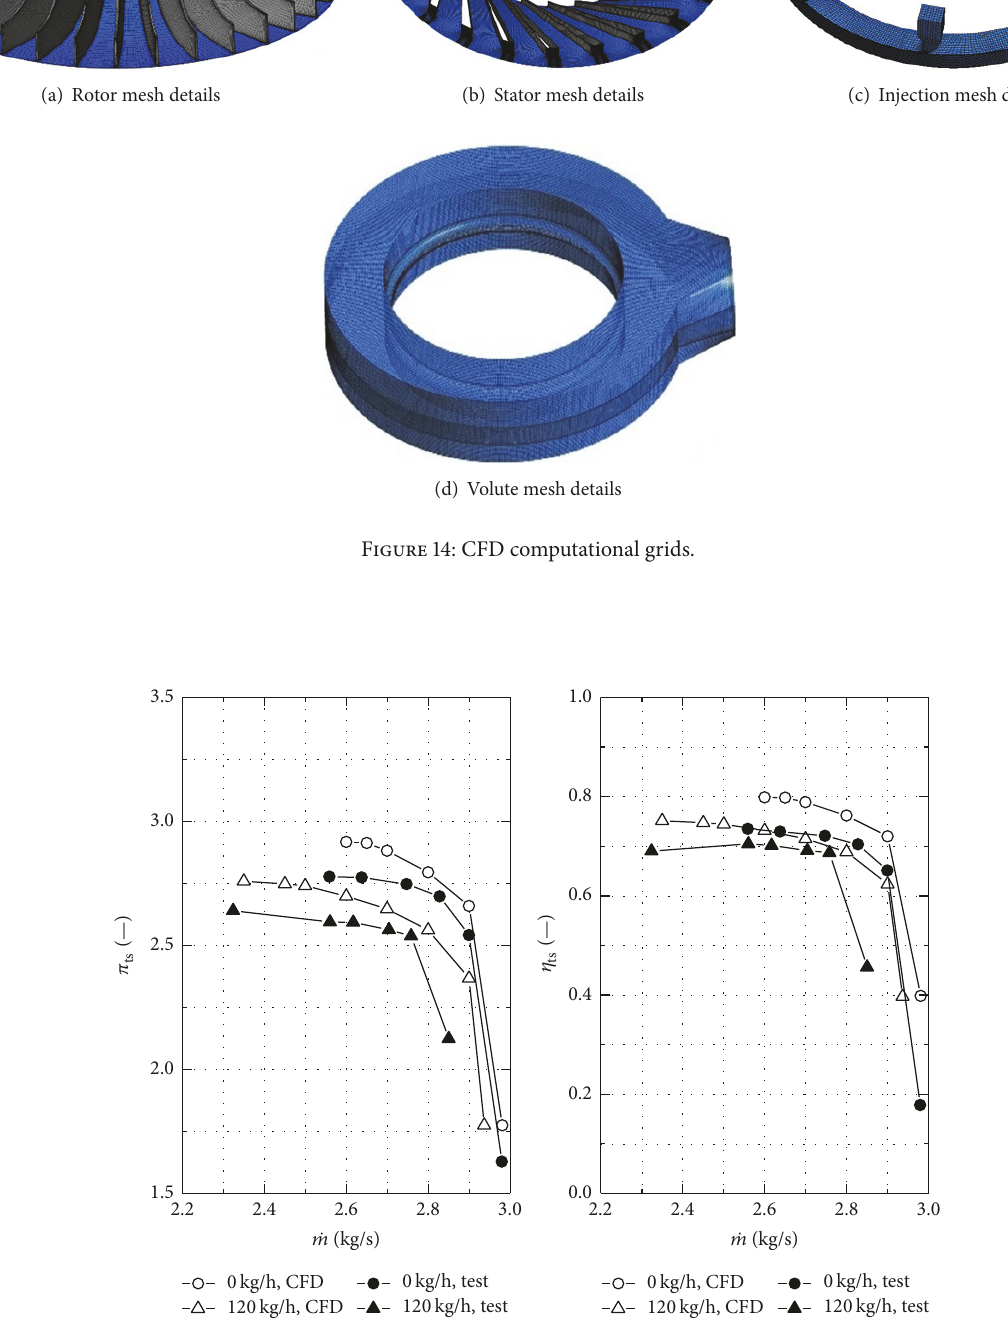
Figure 15: Performance comparison between numerical simulation and test